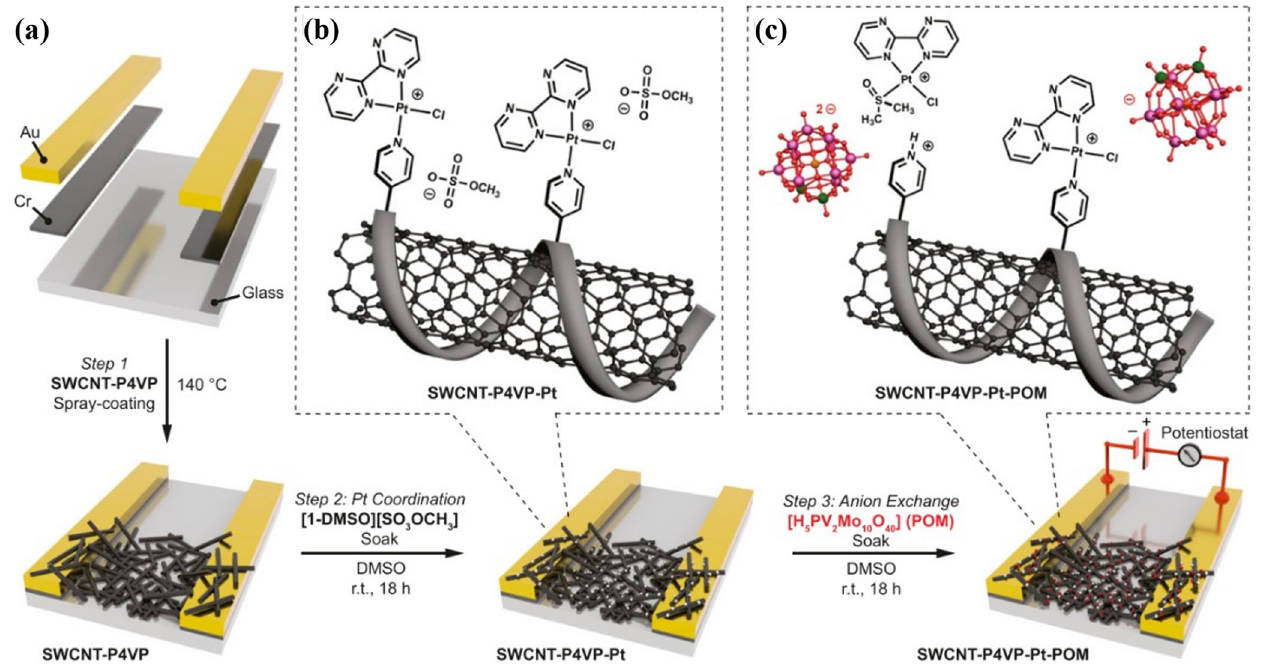
Figure 10. Diagram of device fabrication and sensing element composition. ( a ) Sensor fabrication including spray coating of an SWCNT − P4VP network, Pt coordination and anion exchange ( b , c ). Proposed surface speciation of ( b ) SWCNT − P4VP − Pt and ( c ) SWCNT − P4VP − Pt − POM. Reproduced with permission from Ref. [43]. Copyright 2021 National Academy of Sciences.